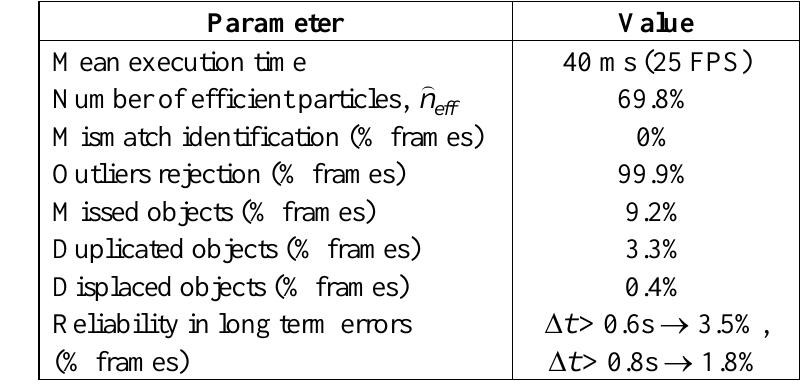
Table 2. Summary of the results obtained with the multi-tracking proposal in a long and complex experiment. The most relevant parameters in the XPFCP are tuned to the values: n = 600, γ = t